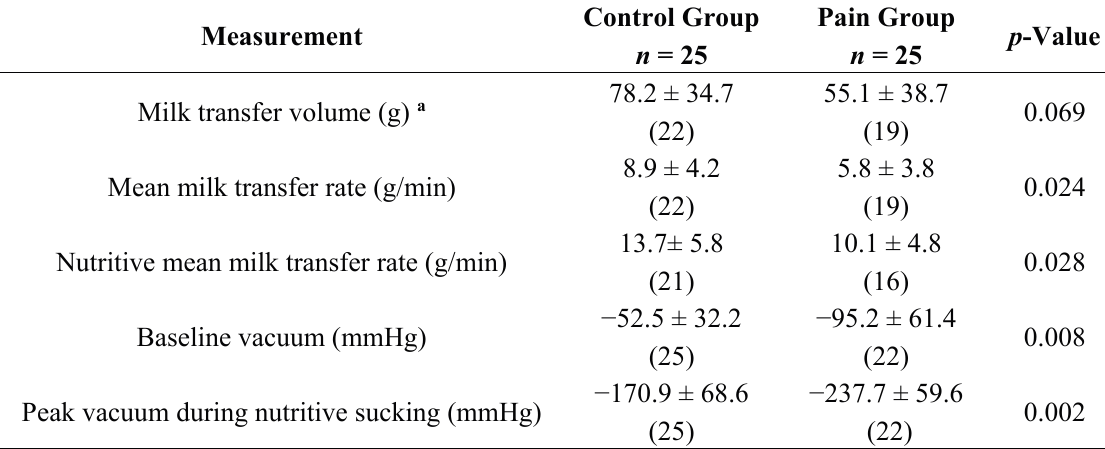
Table 3. Milk transfer and vacuum characteristics for Control group (mothers with no nipple pain) and Pain group (mothers experienced persistent nipple pain during